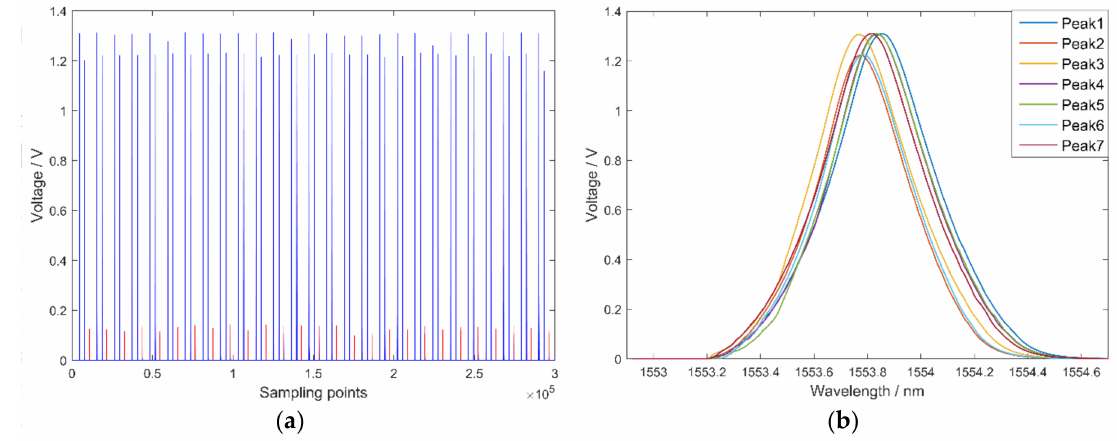
Figure 7. The waveforms of the FBG sensor after filtering: ( a ) reflection spectra of the FBG sensor after filtering; and ( b ) waveforms of seven peaks after filtering.